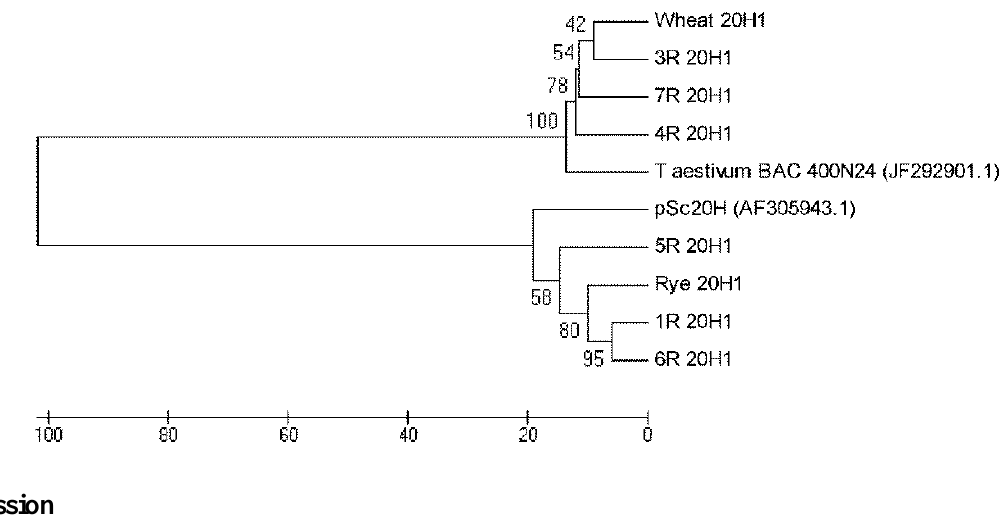
Figure 4. Neighbor-joining tree constructed utilizing the method [25] based on nucleotide alignment of 20H1 internal segments amplified from wheat, rye and wheat-rye addition lines. The numbers on the branches represent bootstrap support for 1000 replicates. The scale indicates the percentage of divergence. Sequences were aligned using Mega software version 5.05 [26] Accession numbers: pSc20H sequence (AF305943) and T. aestivum BAC 400N24